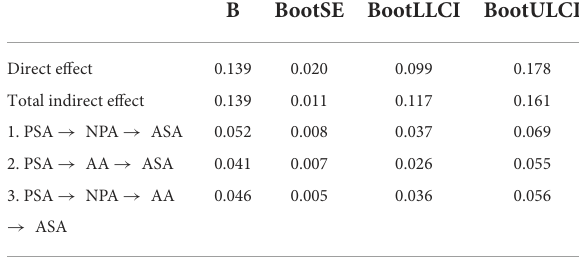
TABLE 4 Direct and indirect relations in the serial multiple mediation model.